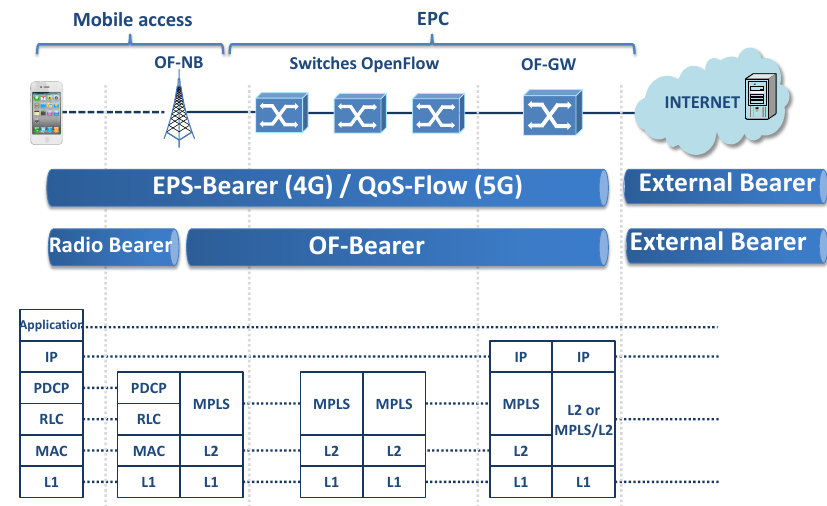
Figure 2. Relationship between Evolved Packet System-Bearer/QoS-Flow with Radio Bearer and the proposed OF-Bearer. MPLS, Multiprotocol Label Switching; EPC, Evolved Packet Core; PDCP, Packet Data Convergence Control; RLC, Radio Link